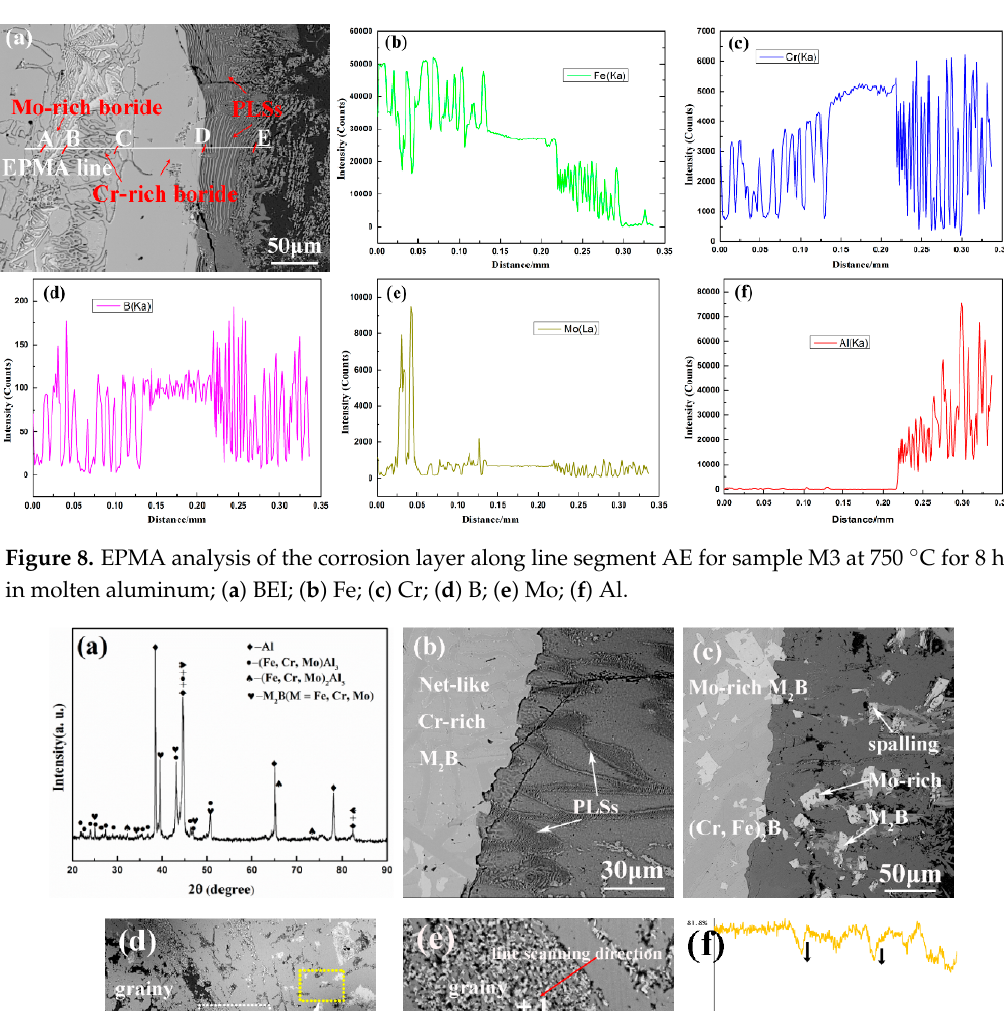
Figure 7. Relationship between the IMC thickness and the corrosion time compared with the interfacial corrosion morphologies of M4 and H13 that were corroded by molten aluminum at 750 °C.